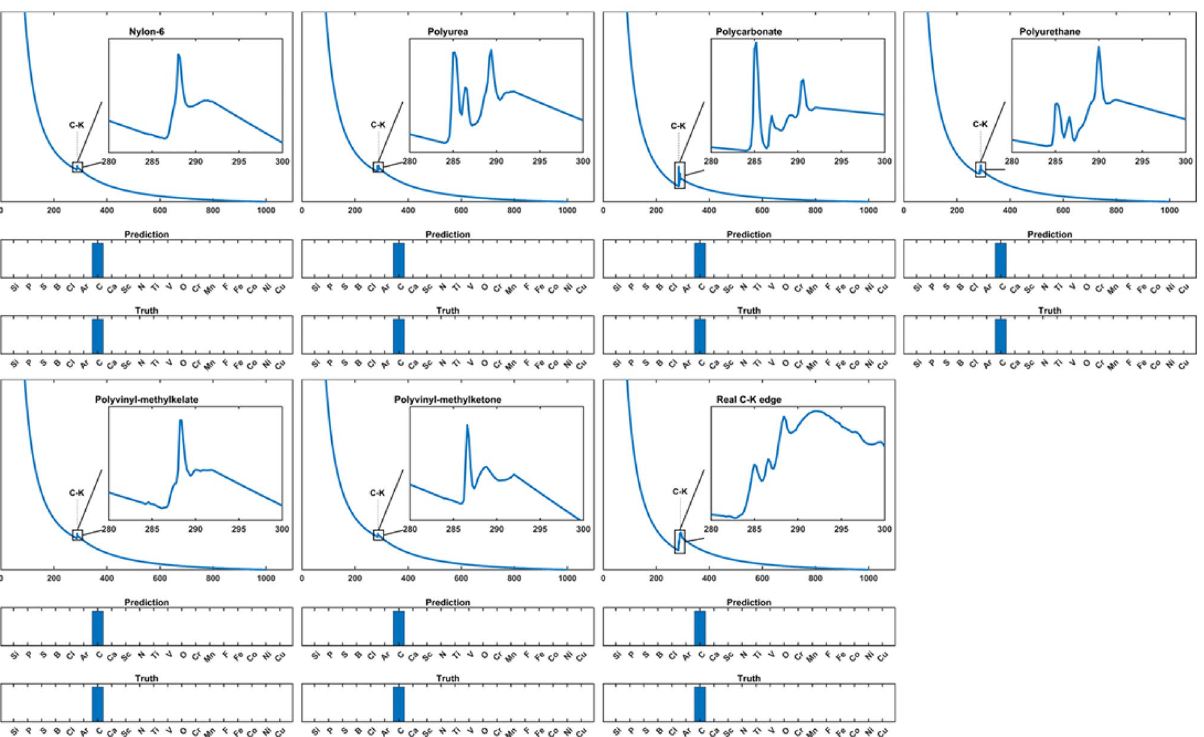
Figure 7. Network prediction versus ground truth for C-K edges from different